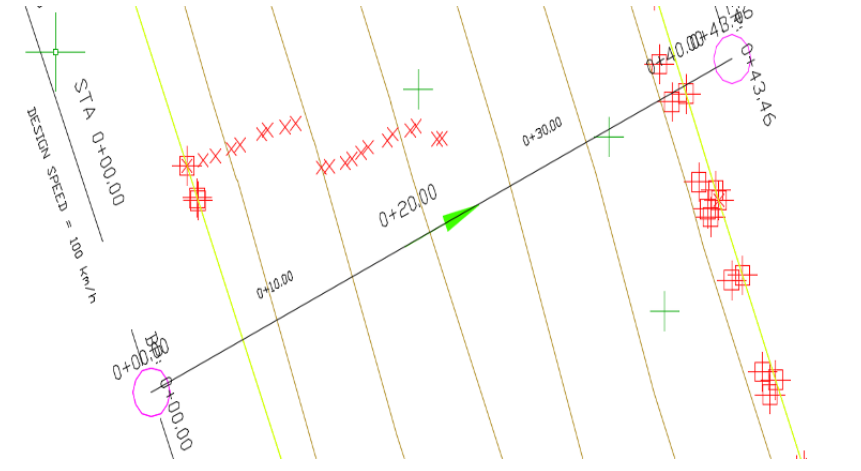
Figure 22 – Creating the cross-lines of a 3D model Рис . 22 – Проектирование линий сечения 3 Д модели Слика 22 – Креирање линије пресека 3 Д